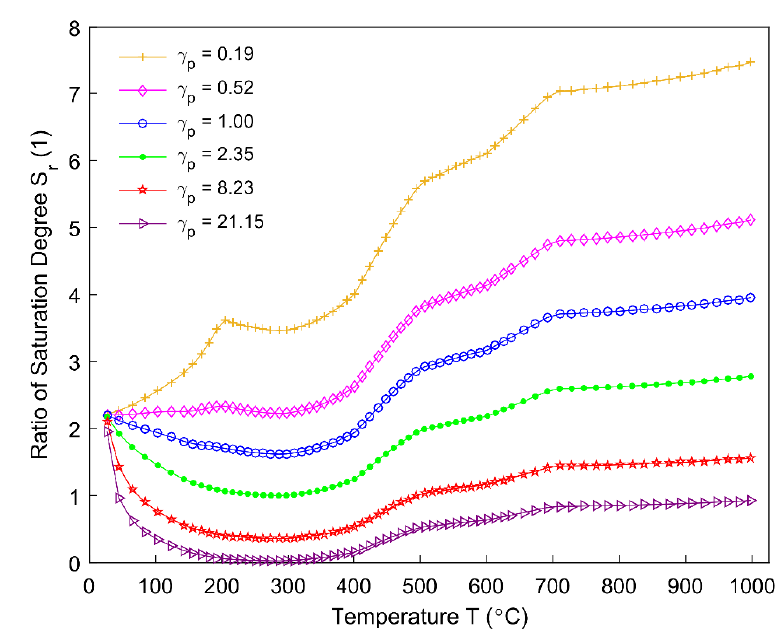
Figure 18. Ratio of saturation degree for different permeability correlators.